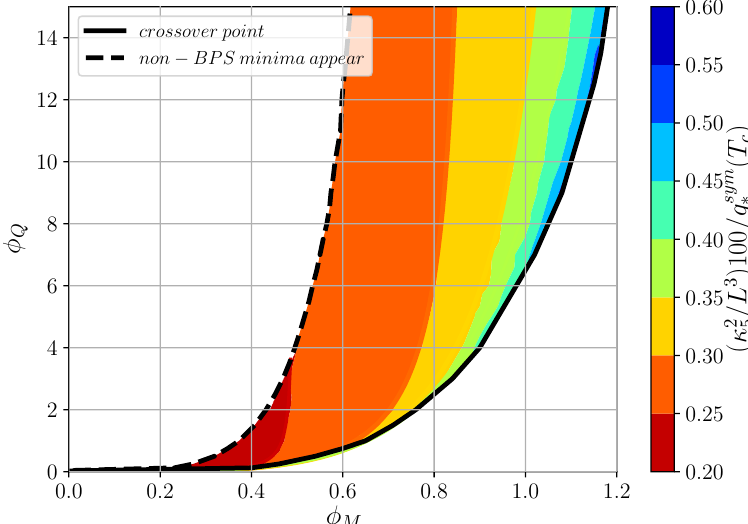
Figure 13 . Contour plot of the ratio of a reference effective number of relativistic degrees of freedom (100) with the holographic degrees of freedom, scaled by the holographic parameters κ 2 symmetric phase at the critical